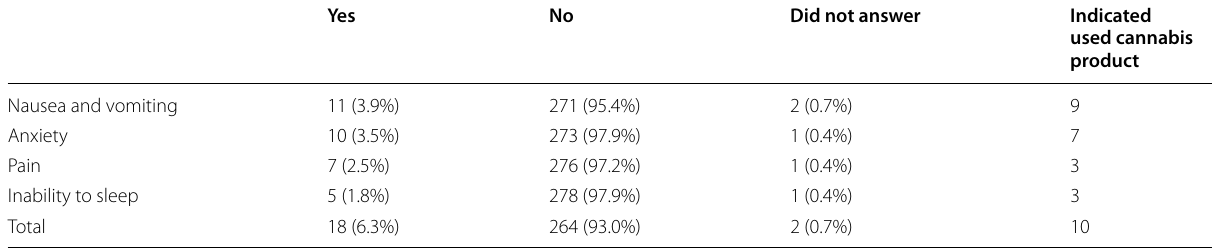
Table 4 Reasons women disclosed for self-medication with alcohol/tobacco/marijuana/other drugs in pregnancy. Many women selected more than one